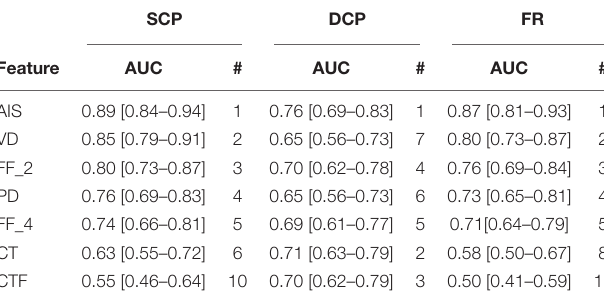
TABLE 1 | Top five area under curve (AUC) values obtained when the task was to perform separation between eyes with diabetic retinopathy (DR) and control group.